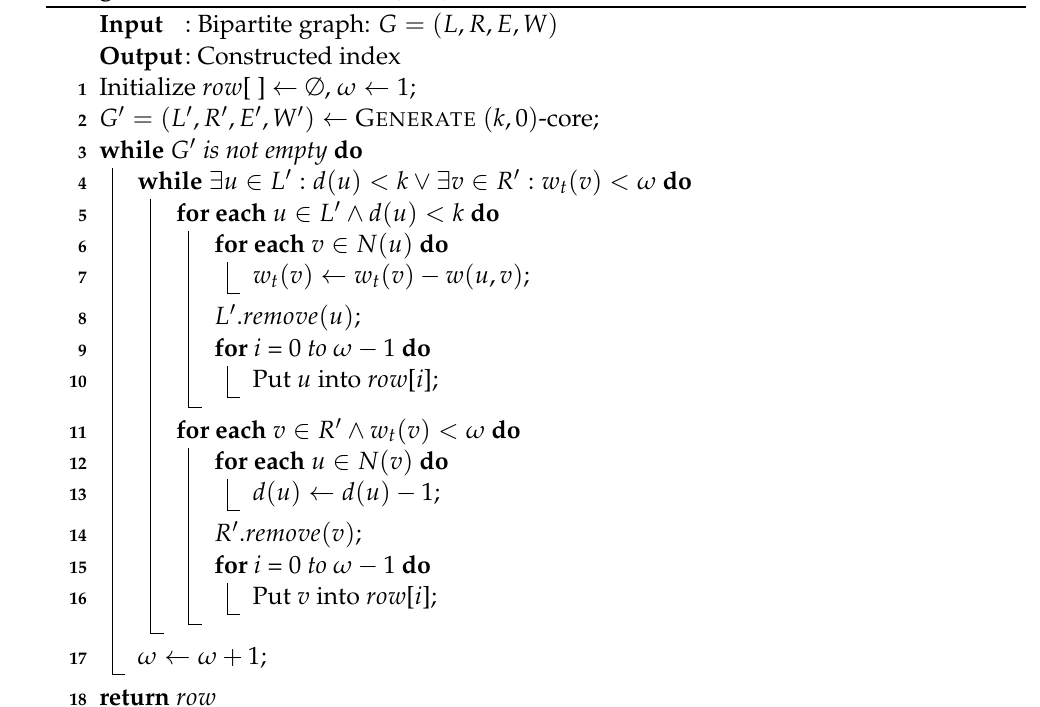
Algorithm 2 : C OMPUTE R OW ( k , G